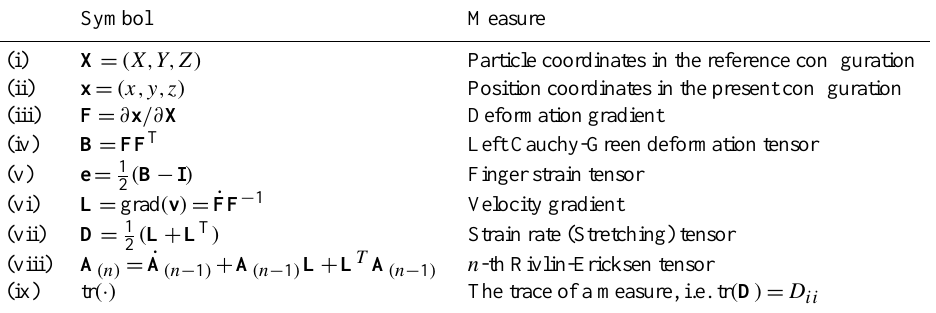
Table 1. Definition of kinematic tensor quantities in Eulerian notation. In index notation, the tensor quantity is non-bold and indexed (i.e. L ˆ= L ij ) . The material derivative ˙ () is given as ∂() A ( 1 ) = 2 D